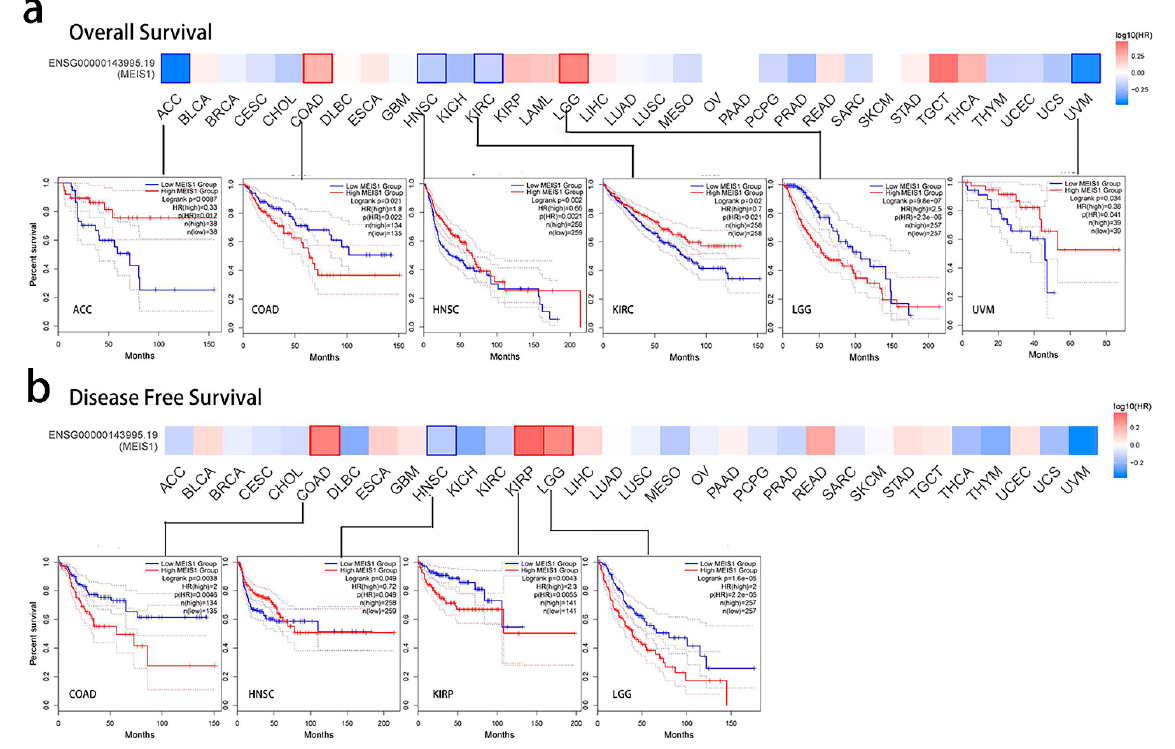
Figure 2. Correlation between MEIS1 expression and survival of patients of cancers in TCGA. The survival plots and Kaplan - Meier curves with positive outcomes were given. ( a ) Correlation between MEIS1 expression and OS of ACC, COAD, HNSC, KIRC, LGG and UVM patients. ( b ) Correlation between MEIS1 expression and DFS of COAD, HNSC, KIRP and LGG patients.